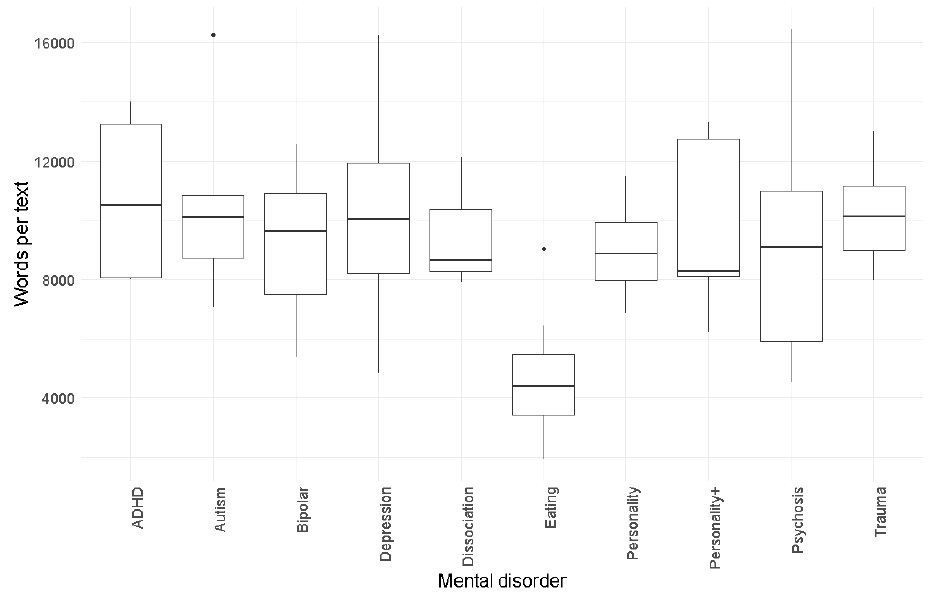
Figure 2. Boxplot of number of words per mental disorder in the